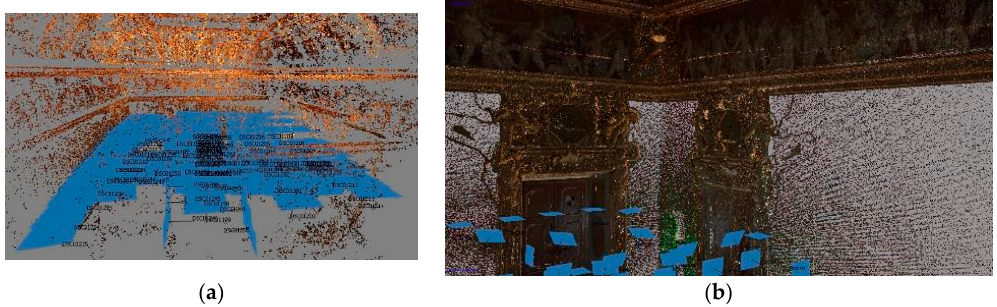
Figure 19. ( a ) The oriented images block in the Fleur-de-lis Chamber ; ( b ) The Photoscan Pro Graphic User Interface (GUI) allows for importing external integrated point cloud for the fusion-based mesh triangulation.